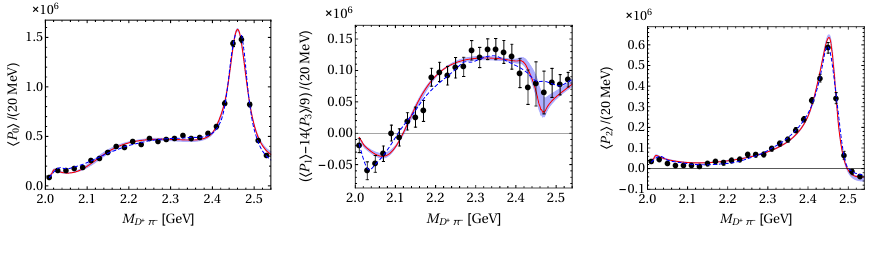
Figure 1. Fit to the LHCb data for the angular moments (cid:104) P 0 (cid:105) , (cid:104) P 1 (cid:105) − 14 (cid:104) P 3 (cid:105) / 9 and (cid:104) P 2 (cid:105) for the B − → D + π − π − reactions [44,